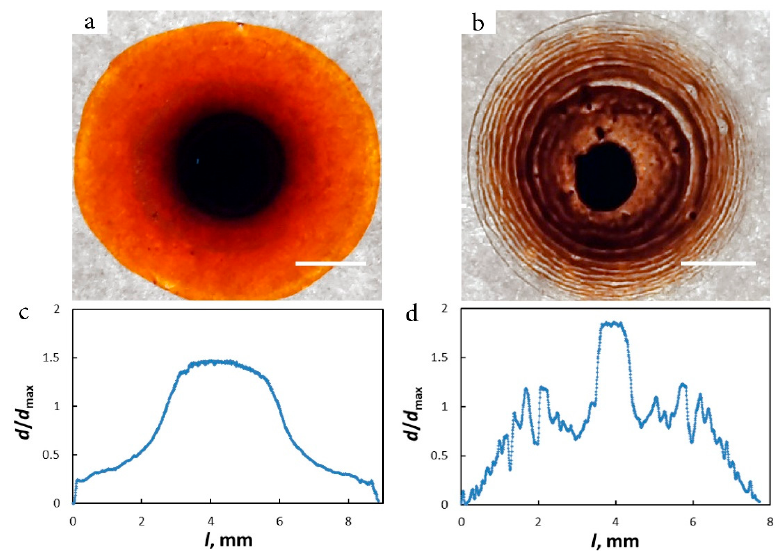
Figure 3. Visual appearance and relative thickness profiles of precipitates formed on a glass sub- strate under the influence of a non-homogenous magnetic field after evaporation of sample drops No. 1 ( a , c ) and No. 2 ( b , d ). Scale bars are 2 mm.